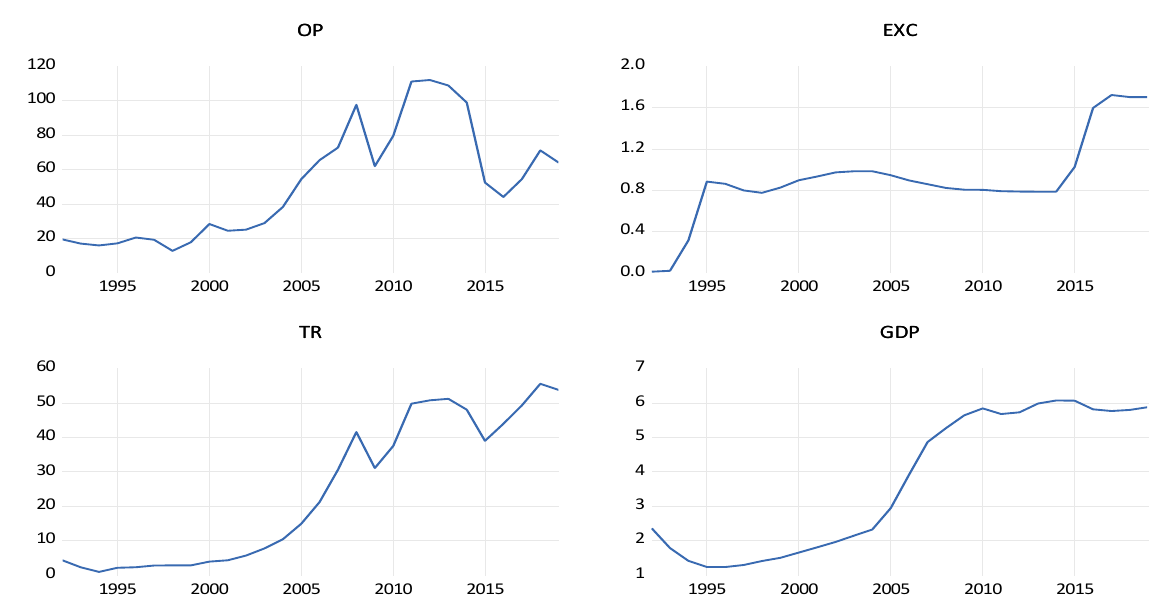
Figure 1. Plots of used variables; OP = Oil prices (dollars per barrel), EXC = Exchange rate (Azerbaijani manat per U.S. dollar), TR = Total trade turnover (million dollar), GDP = GDP per capita (thousand dollars); Source: [43].